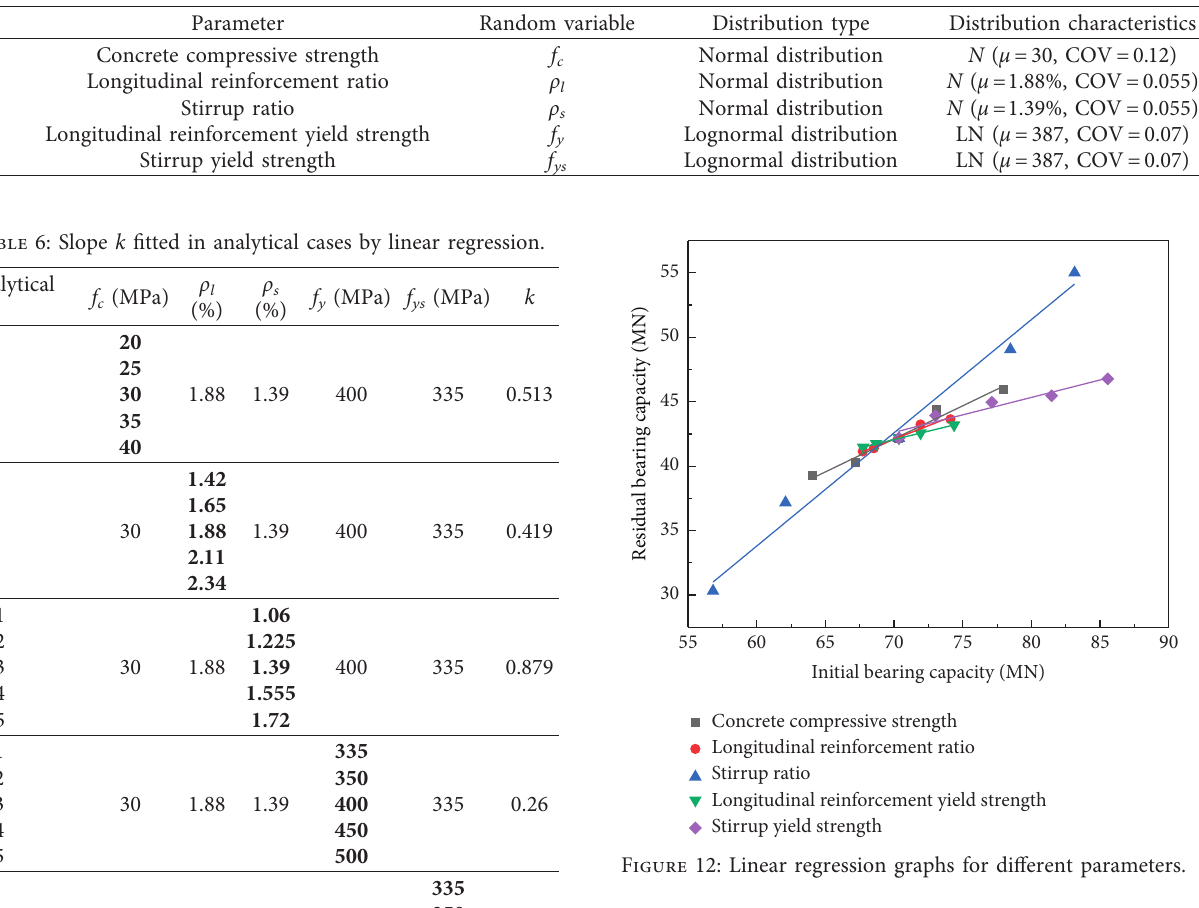
Table 5: Distribution characteristics of the main parameters.